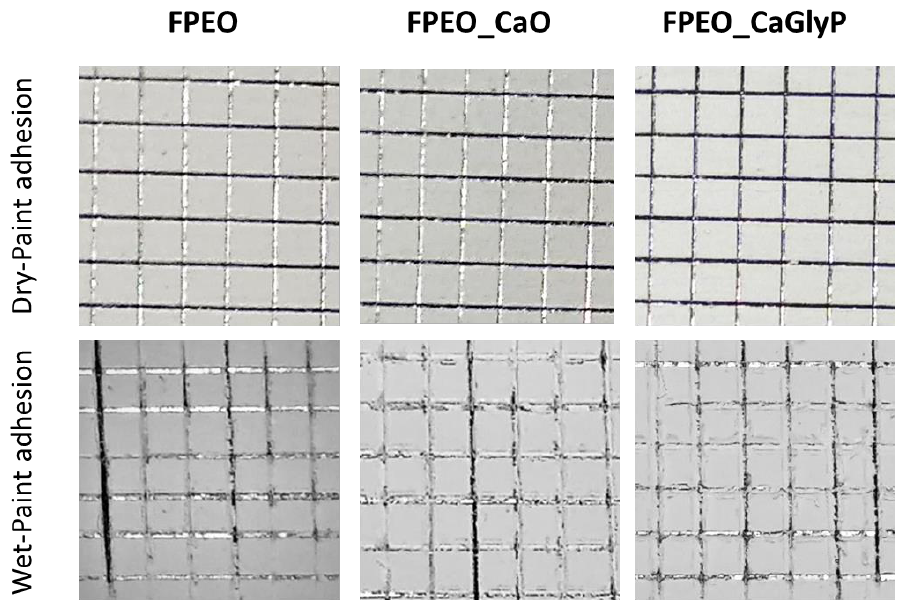
Figure 10. Cross-cut dry and wet paint adhesion test results on the flash-PEO coatings. Macro-views of the corroded surface area of the painted and scribed specimens after NSST are